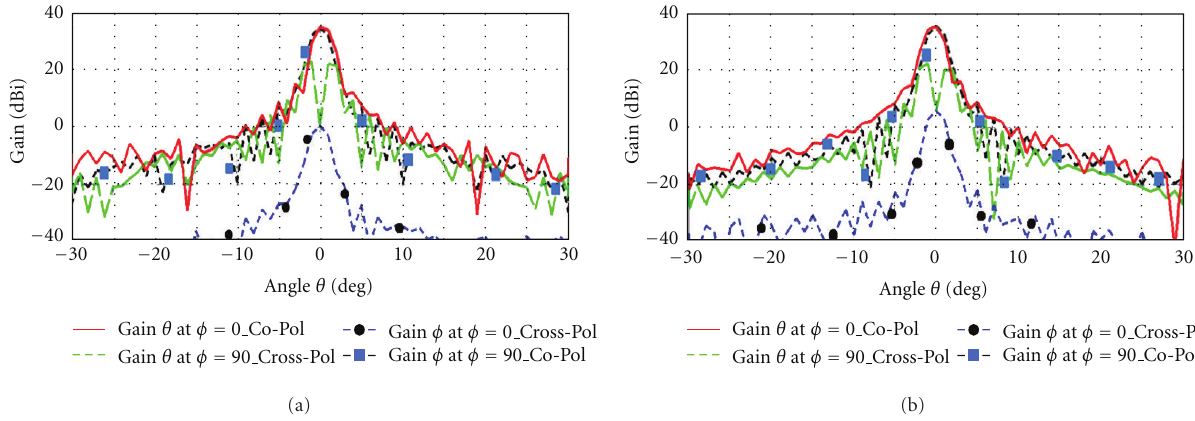
Figure 14: Reflector antenna radiation patterns at 7.73 GHz with the feedhorn mode combination of TE 11 (50%) + TM 01 (50%) for (a) +90 ◦ and (b) − 90 ◦ phase values.